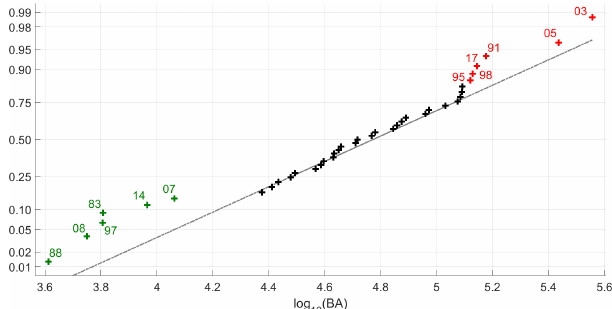
Figure 2. Normal probability plot comparing the sample of log 10 BA to the normal distribution. The groups of severe and weak years are marked in red and green respectively and the years are identified by the two digits next to the symbols.